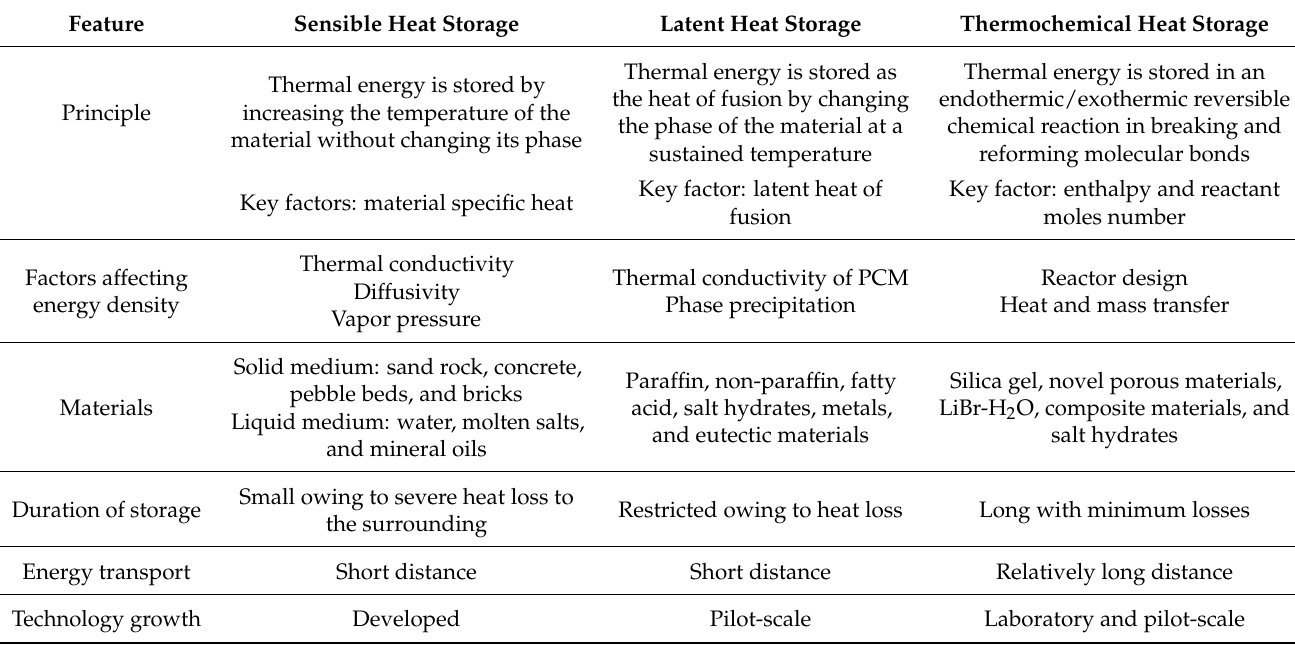
Table 5. Brief overview of storage systems